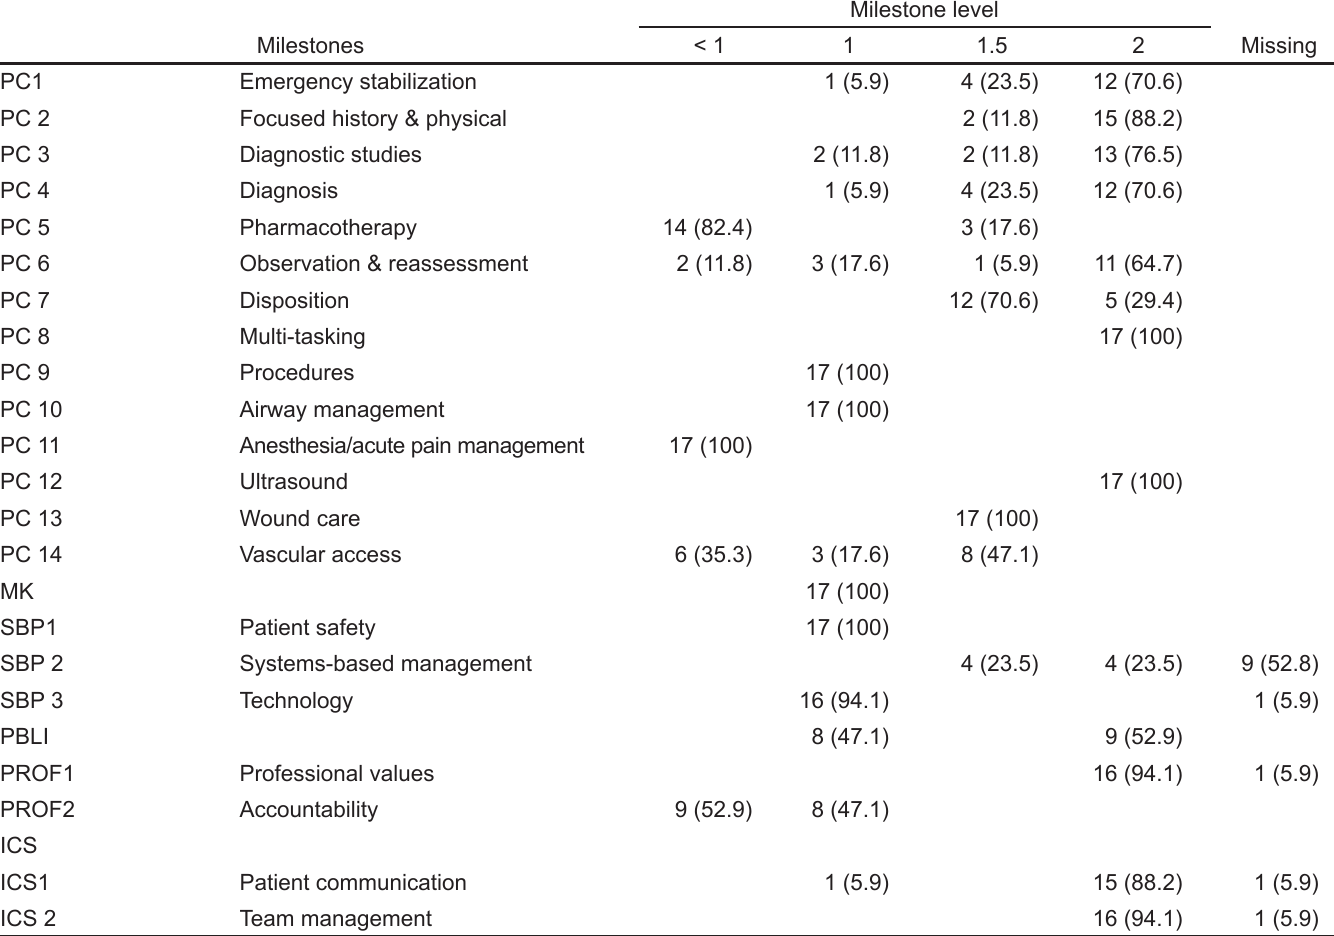
PC, patient care; SBP , systems-based practice; PROF, professionalism; MK, medical knowledge; PBLI , practice-based performance improvement; ICS , patient-centered